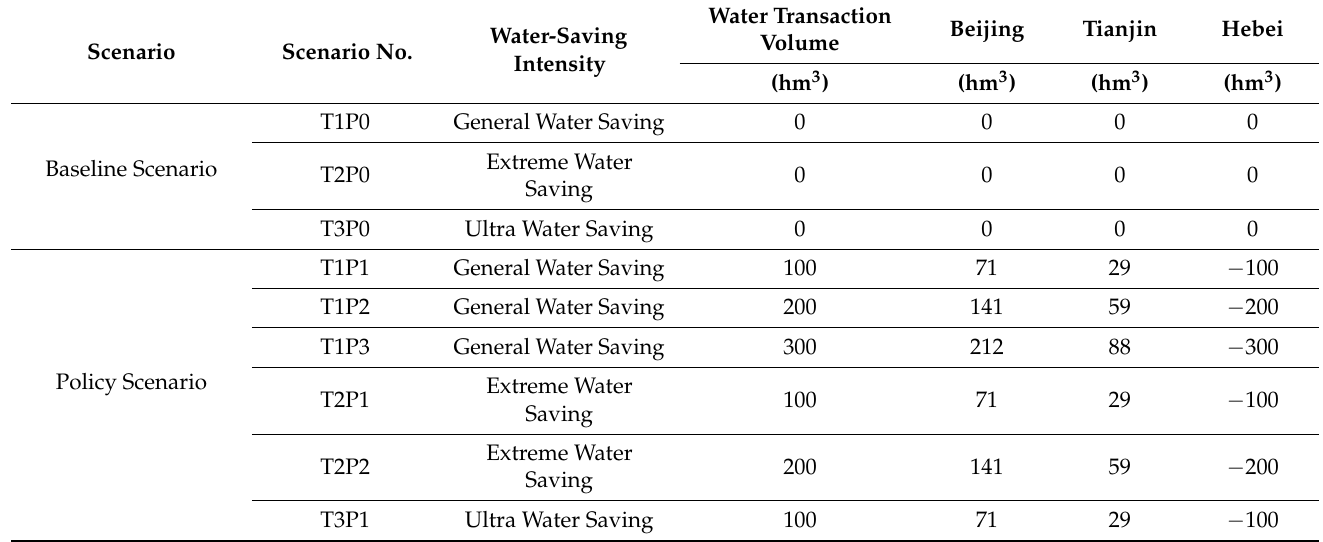
Table 2. Water rights transaction scenarios.